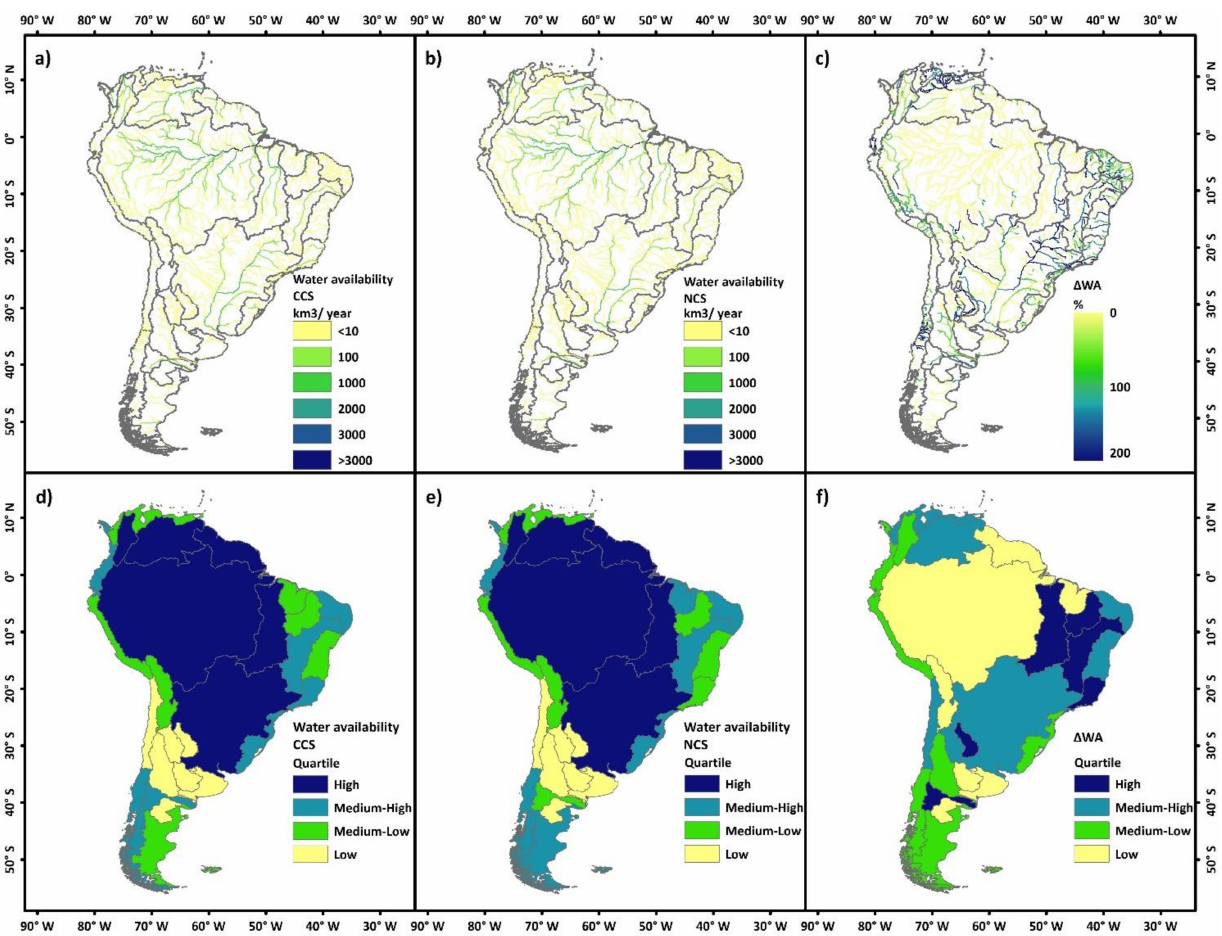
Figure 6. Effects of reservoirs on the availability of water of the hydrological regions in South America. The CCS scenario represents the case scenario of water availability with reservoirs, and the NCS scenario represents the ‘natural’ conditions without reservoirs. Figures ( a – c ) are mapped as flow values and represent water availability in the CCS scenario, water availability in the NCS scenario, and the increment in water availability ∆ , respectively. Figures ( d – f ) represent the water availability values mapped as quartiles. See Table 3 for specific